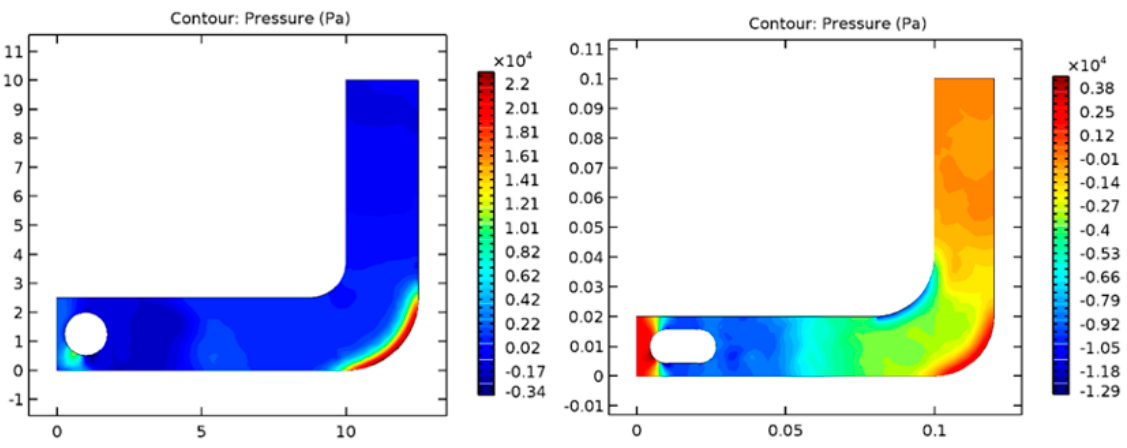
Figure 14. Comparison of pressure for spherical ( Left ) and capsule ( Right ) geometries in the GI tract.